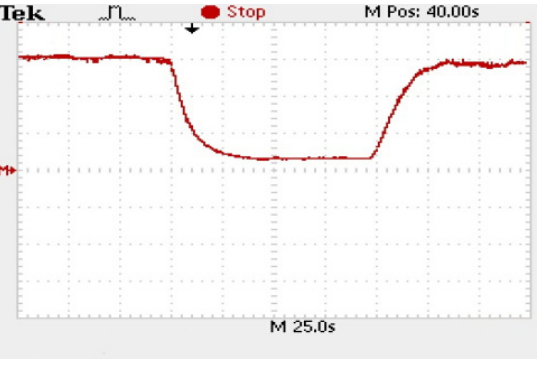
Figure 15. Maximum power test. Sliding Mode Extremum Seeking Control, fixed wind speed of 8 m/s.